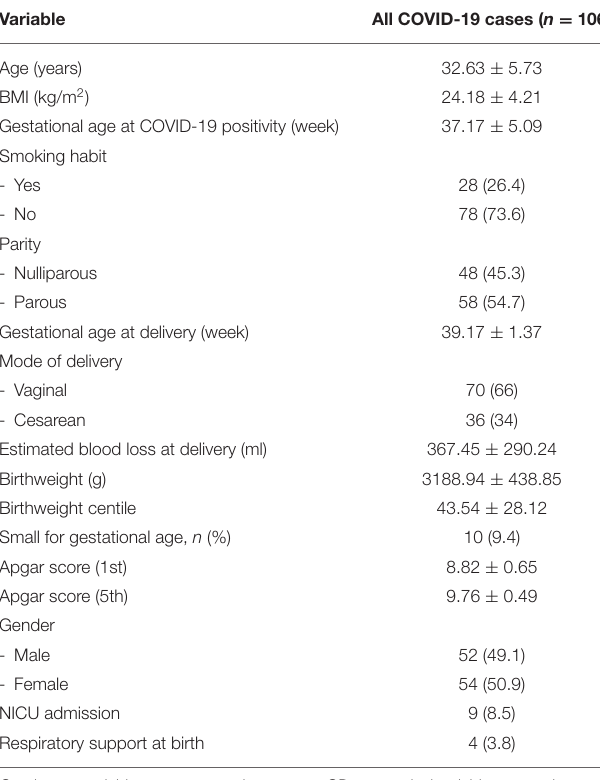
TABLE 1 | Demographic, clinical maternal characteristics, and neonatal outcome.